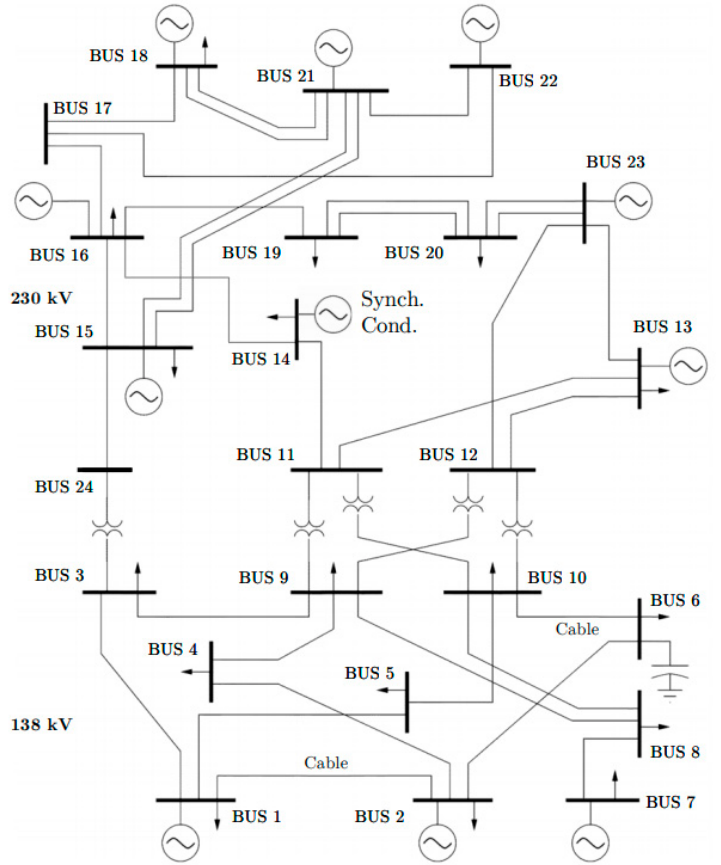
Figure 3. A single-line diagram of the RTS-96 test system—the first test system in the